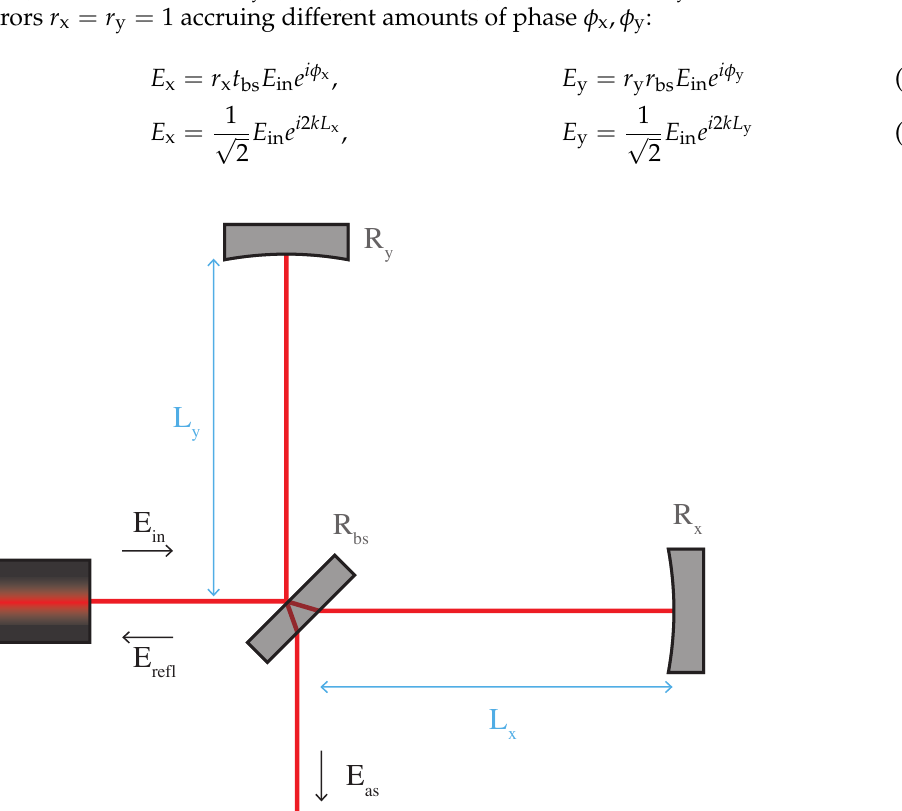
= 1/2 reflects half the laser power to the Y-arm and bs R y 1 send most of the light ≈ ≈